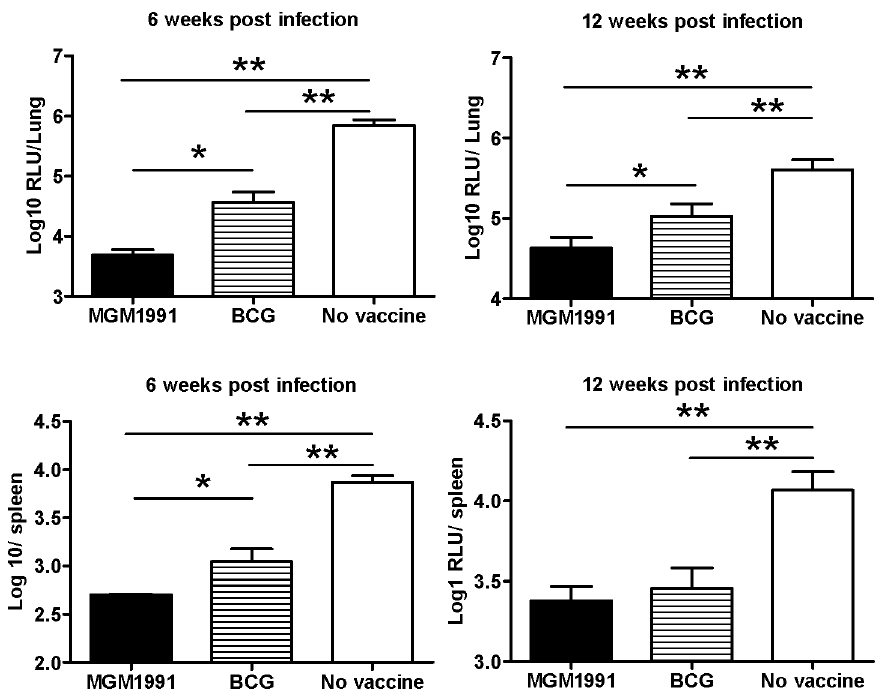
Figure 7. Bacterial replication in lungs and spleen of BALB/c mice vaccinated with MGM1991, or BCG and challenged with 10 5 CFU of virulent luminescent M. tuberculosis . Mean number of bacteria in lungs and spleen of C57BL/6 mice vaccinated with 5x10 5 CFU of MGM1991 mutant or BCG or unvaccinated mice (naïve), challenged 12 weeks later with 10 5 CFU of virulent M.tb by the intratracheal route and sacrificed 6 or 12 weeks after challenge. Results are reported as mean log SD of 5 mice tested individually; * P < 0.05; ** P < 0.01 (Mann-Whitney test).